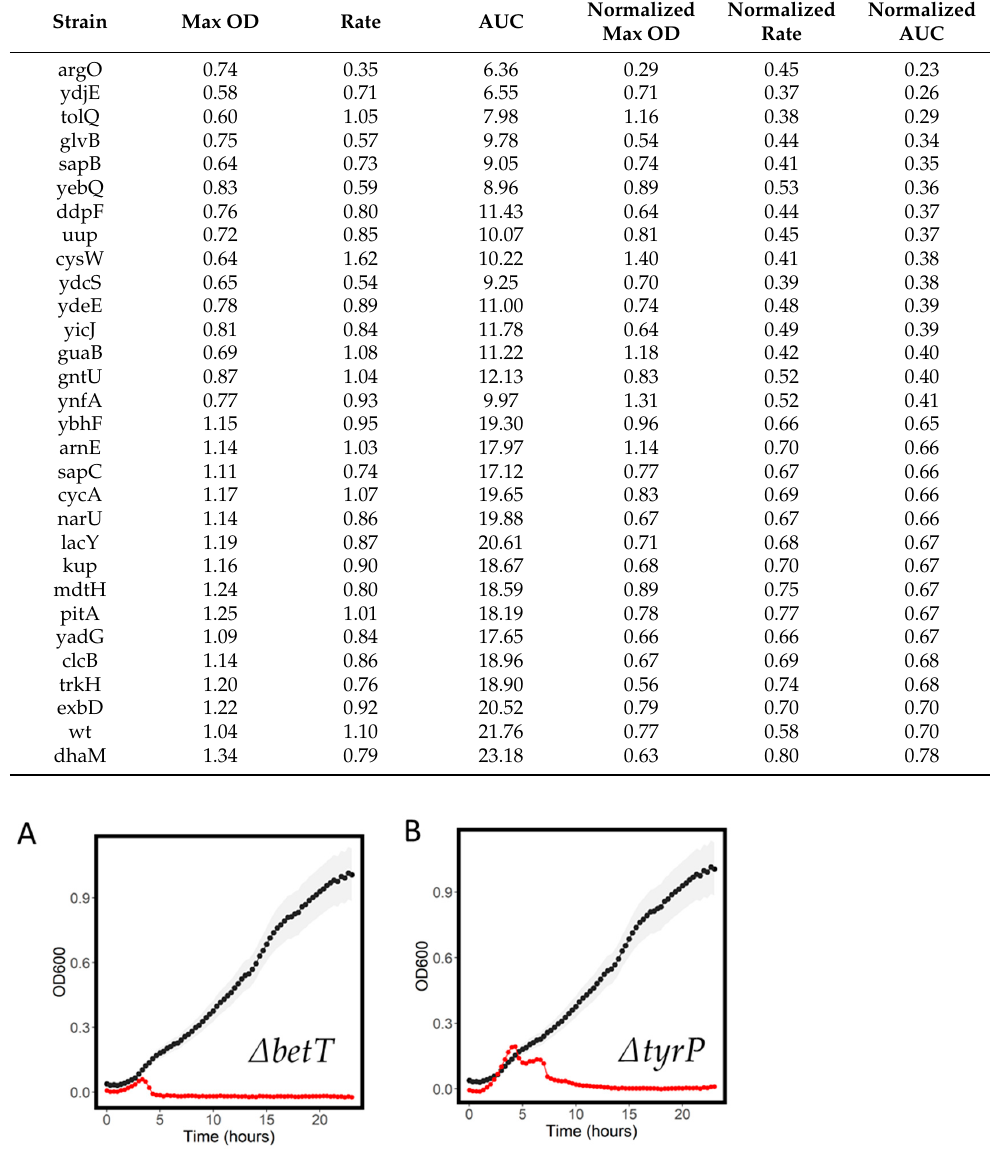
Table 2. Growth parameters for the 15 most sensitive and most resistant strains in Ornidazole by normalized AUC. Normalized values show the value in ornidazole/value in LB for the given strain. Strain Max OD Rate AUC